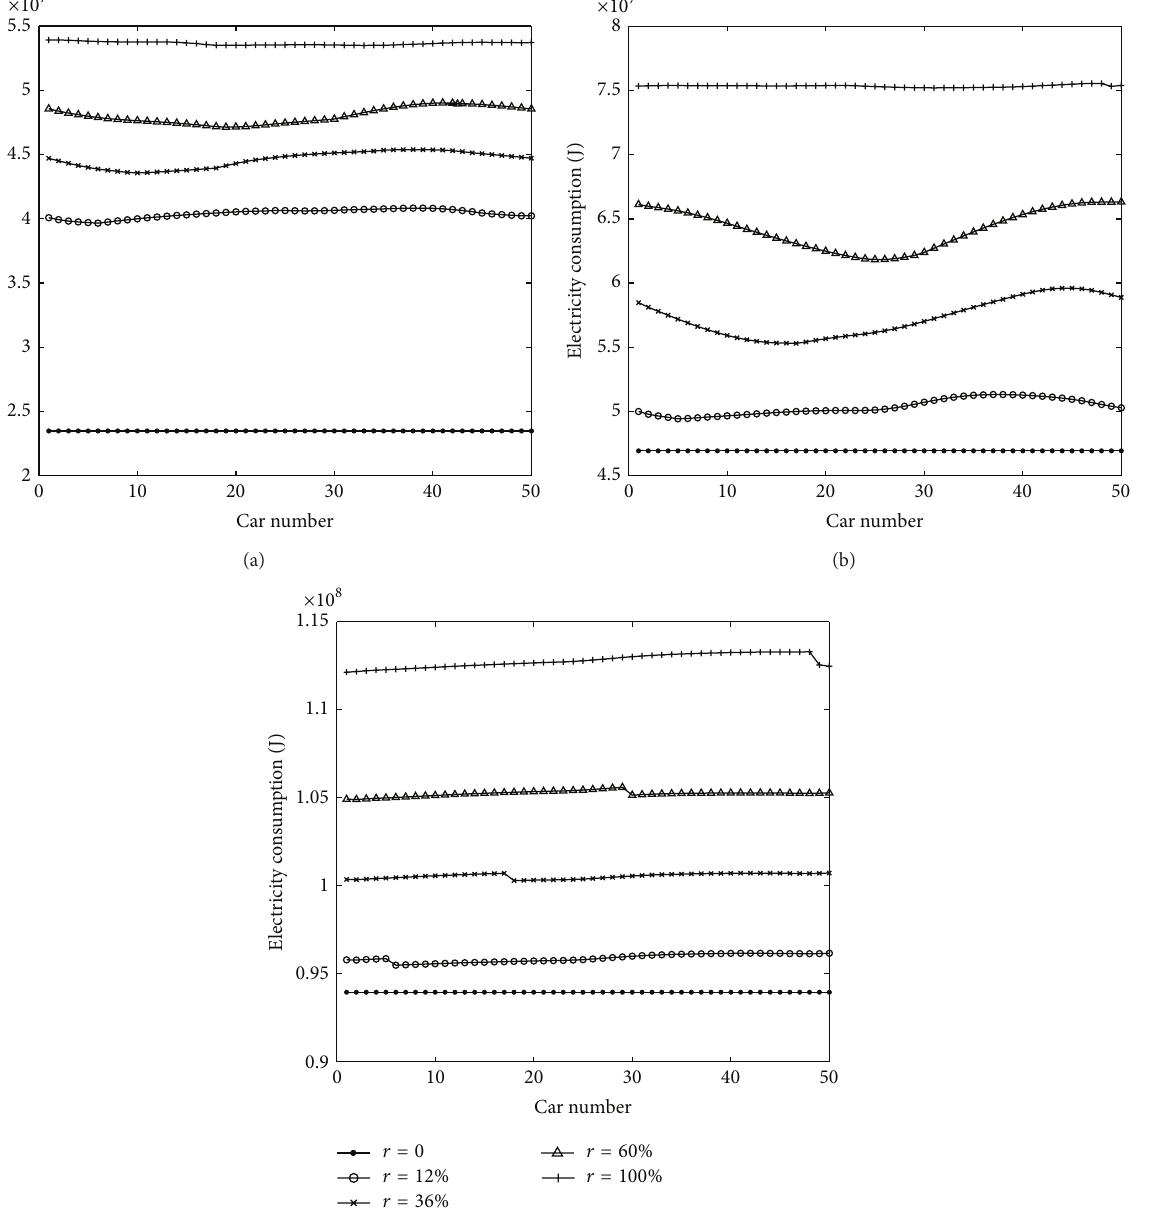
Next, we study the impacts of exchanging battery on each vehicle’s electricity consumption under different 𝑇 0 (see Figure 4). Combining with Figure 3, we find that under the same Δ𝑥 0 , the increments increase with 𝑇 0